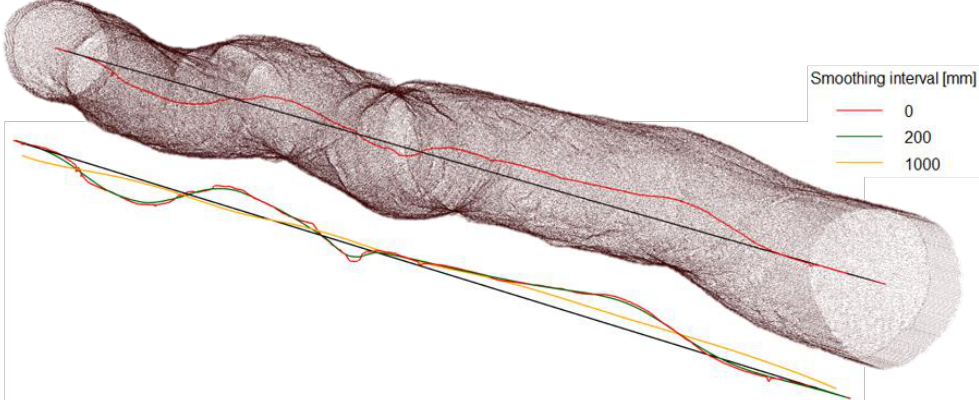
Figure 7. Impact of the smoothing interval (moving average) on center line through a log in the center mass algorithm. The upper image shows a 5.07 m long oak log with the reference line in black and the unsmoothed centerline in red. The centerline after smoothing with two different intervals is shown in the lower part (green and yellow). Table 3. Mean curvature values for the centerline method depending on the smoothing interval used for the calculation of the moving average divided by species. For an interval of 50 mm (C_50), the mean curvature value is 0.78 for the spruce logs, 1.68 for the oak logs and 1.05 for the pine logs. Species C_50